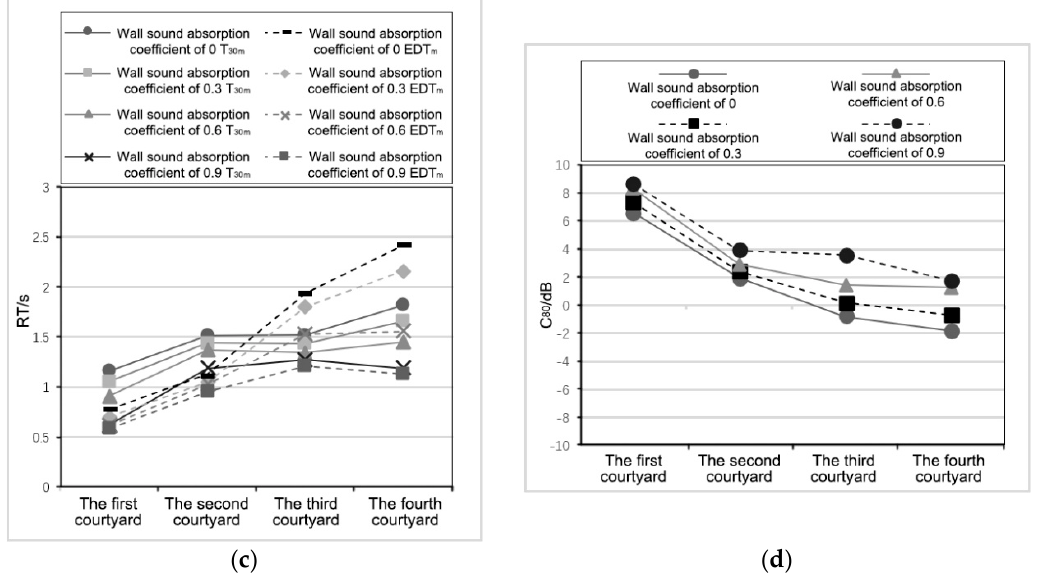
Figure 11. Diagrams of the effects of wall materials on courtyard sound fields. ( a ) Variation in SPL(A). ( b ) Variation in the standard deviation of SPL(A). ( c ) Variation in RT. ( d ) Variation in C 80 . Courtyard grounds of traditional Buddhist temples are generally paved with hard bricks or stones, with partial areas of natural vegetation (greenery) or bare soil. In this study, each courtyard’s sound field was simulated with three di ff erent courtyard ground compositions: 100% greenery, 100% bare soil, or 100% stone pavement. Figure 12a shows that there was almost no di ff erence in SPL(A) between courtyard sound fields with ground compositions that were either greenery or bare